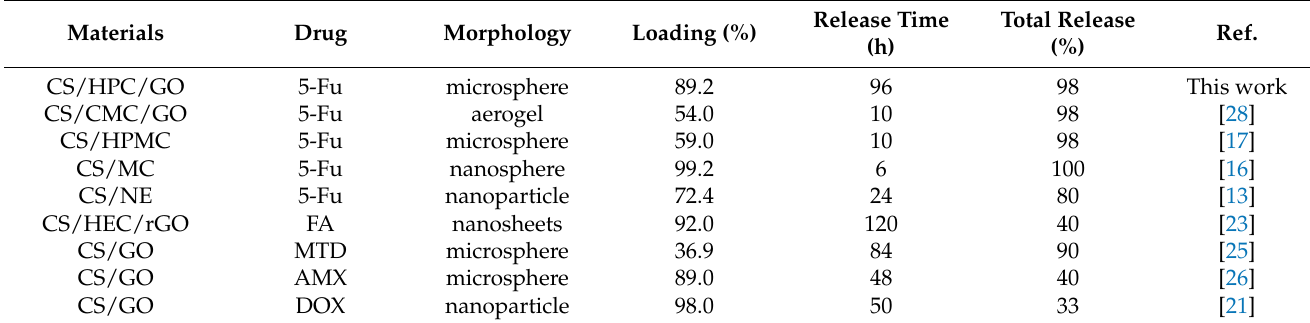
Table 3. Drug carrier materials based on GO and CS